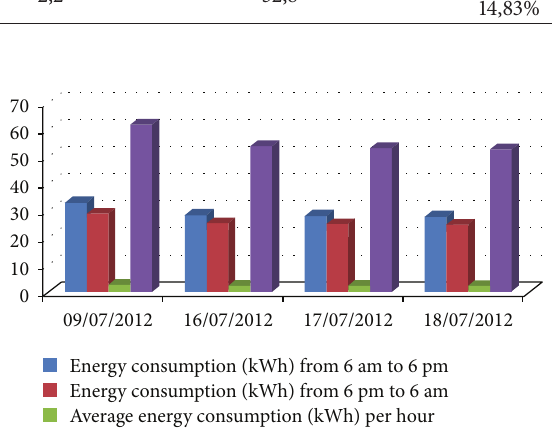
Figure 12: Comparison between energy consumption of the site, case of a day not applying the proposals of energy savings (06/07/2012), case of a day for which the air conditioner was under failure and case of days applying the proposals of energy savings (16, 17, and 18 July 2012): Missinguileo site.